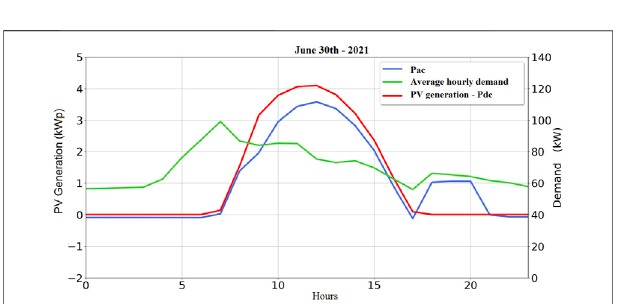
FIGURE 8 | The PV generation pro fi le with maximum hourly irradiation days for the academic weekday - 06/30/2021 versus average hourly demand of June/2019. Data Sources: the authors.